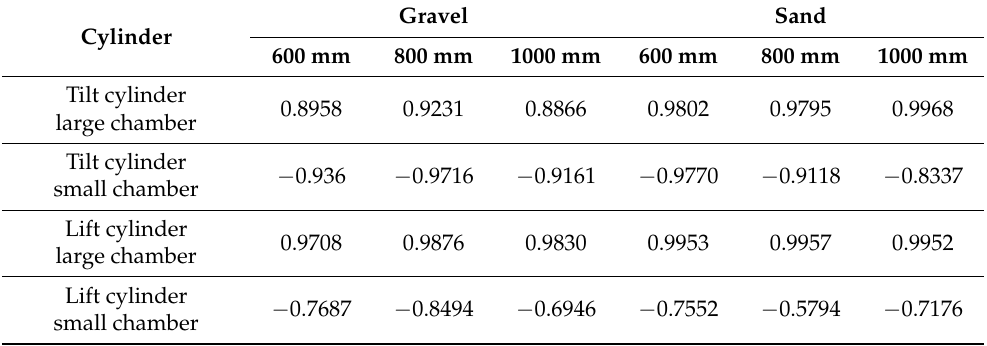
Figure 13. Cylinder pressure data. ( a ) Tilt cylinder for gravel sample; ( b ) Lift cylinder for gravel sample; ( c ) Tilt cylinder for sand sample; ( d ) Lift cylinder for sand sample. Table 2. Pearson correlation